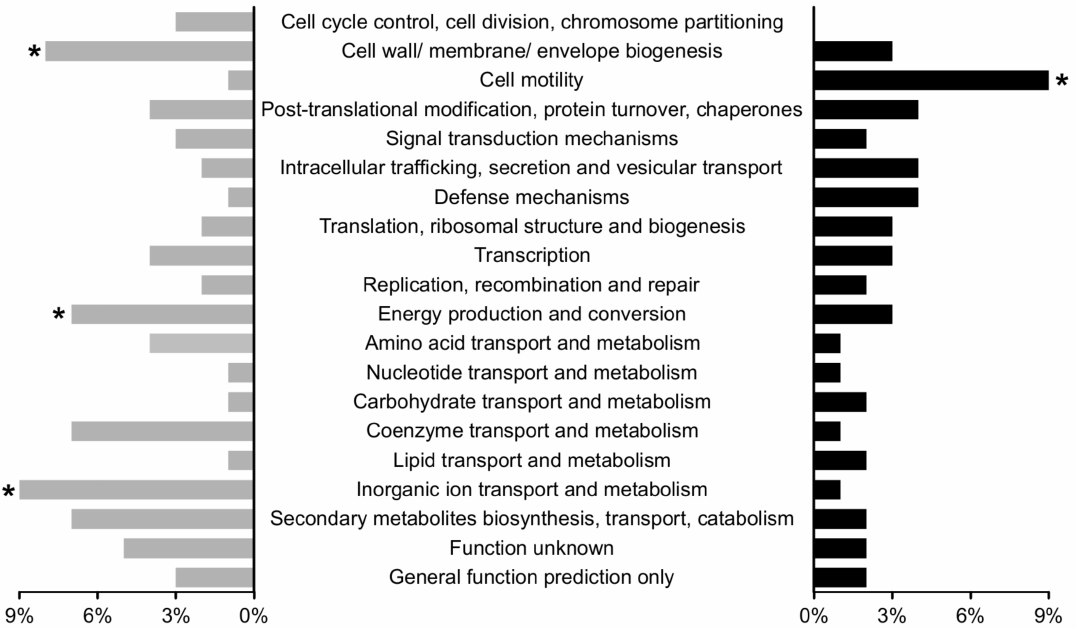
Figure 2. Functional categories of the top 500 differentially expressed genes in P. phymatum nodules infected by the wild type versus an rpoN mutant during symbiosis, with P. vulgaris (genes up-regulated in the rpoN mt are in black, those that were down-regulated are in grey) according to classification by eggNOG [40]. Percentages were calculated by dividing the number of significantly up-regulated (322) or down-regulated (178) genes in each category by the total number of retained genes in the same category. The asterisks (*) indicate statistical significance (Fischer test, p -value <